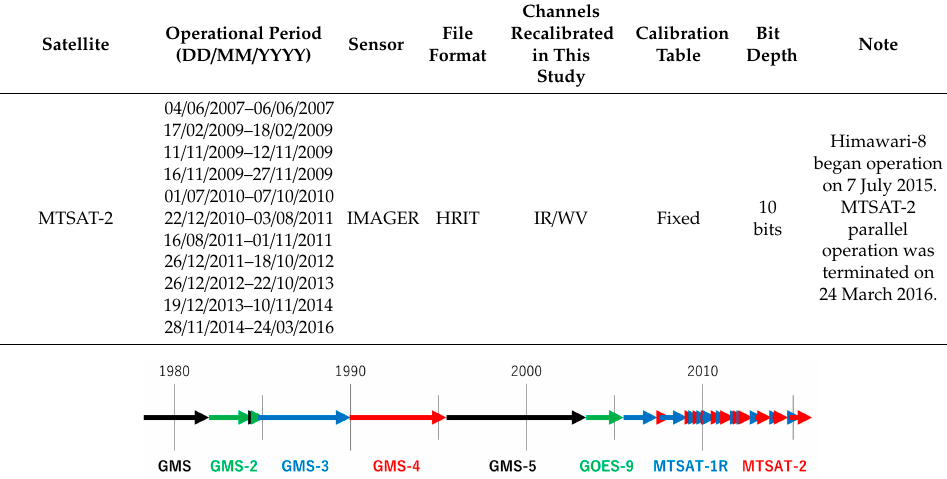
Figure 1. Graphical representation of operational periods of JMA’s historical geostationary satellites and sensors.